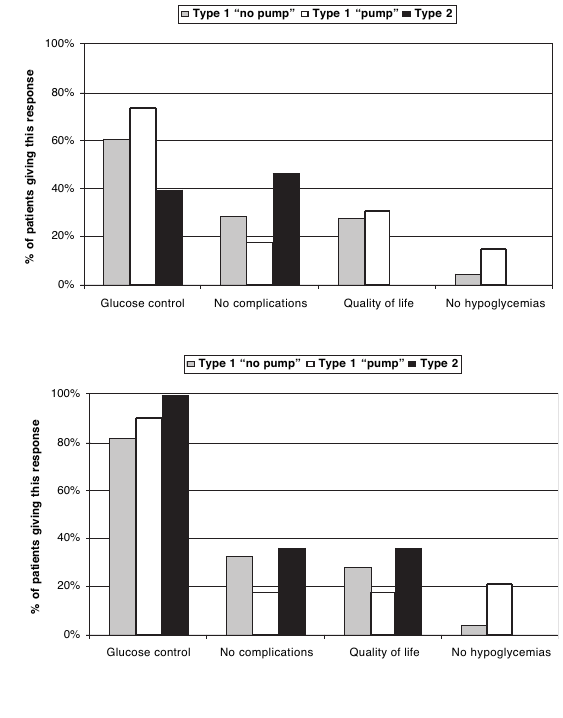
Patients’ treatment goals (A) and their perception of their physicians’ goals (B). The treatment goals of type 1 diabetic pa- tients treated without (type 1 “no pump”) and with an insulin pump (type 1 “pump”) and insulin treated type 2 dia- betic patients and of their physicians are shown in descending order from left to